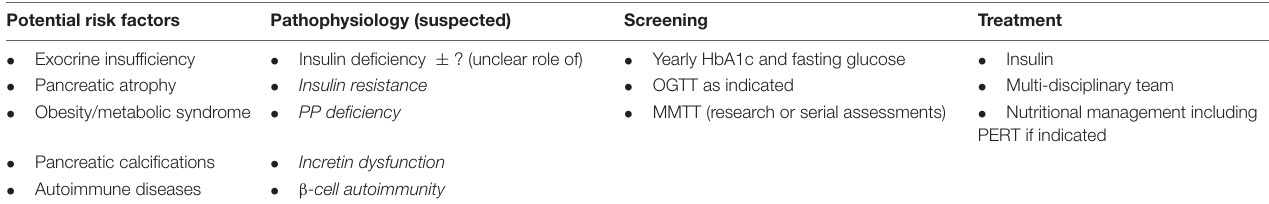
TABLE 1 | Summary of the potential risk factors for and pathophysiology of pancreatogenic DM in children with ARP and CP, and screening and treatment recommendations, limited by a small number of studies in children to date. Potential risk